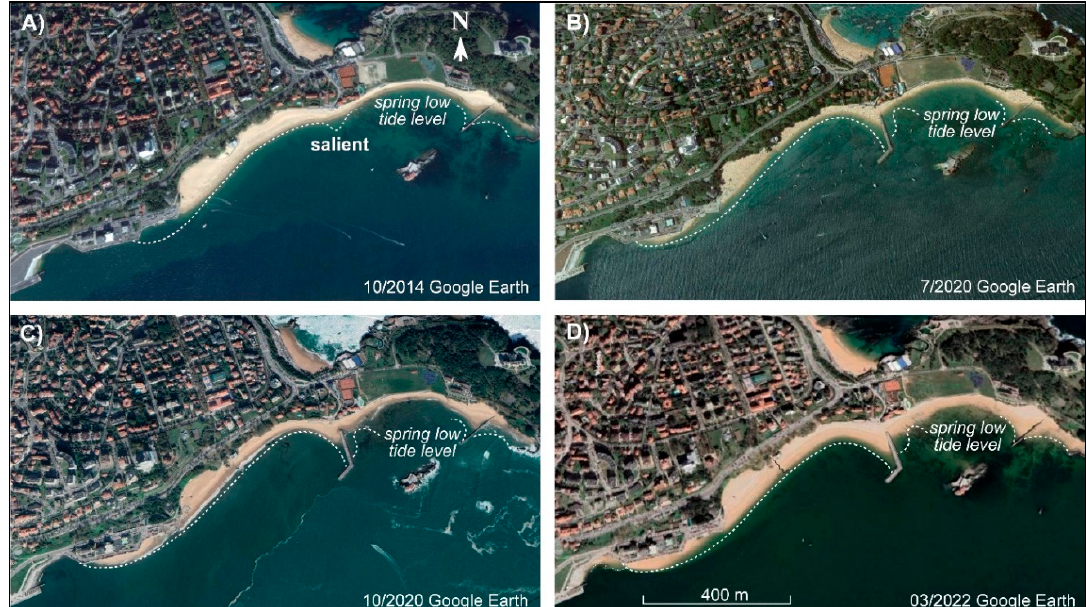
Figure 12. Google Earth satellite images: ( A ) Changes in the beach plan shape of La Magdalena beaches before the construction of the breakwater in 2014. ( B , C ) Afterwards in 2020. ( D ) In 2022, with the profile modified by the redistribution of sediment with machinery. The western Bikini beach grew towards the breakwater, as well as the foreshore of La Magdalena, and the eastern half of La Magdalena